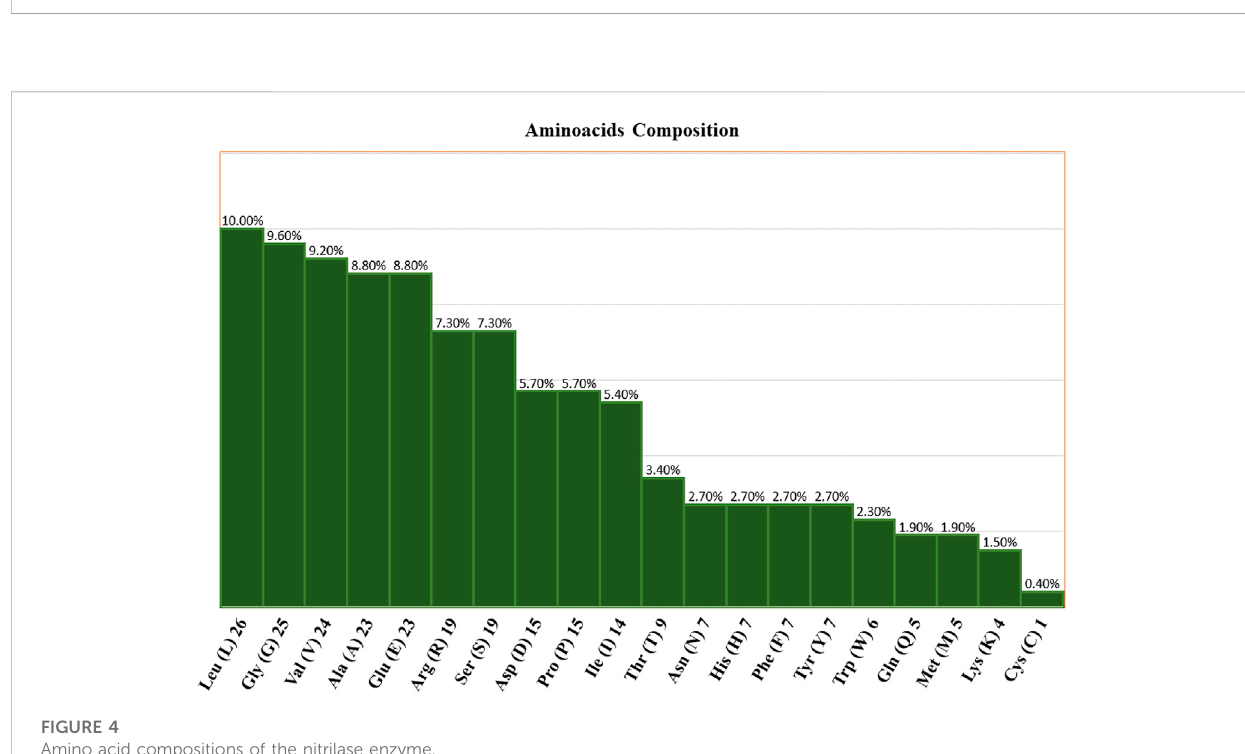
FIGURE 4 Amino acid compositions of the nitrilase